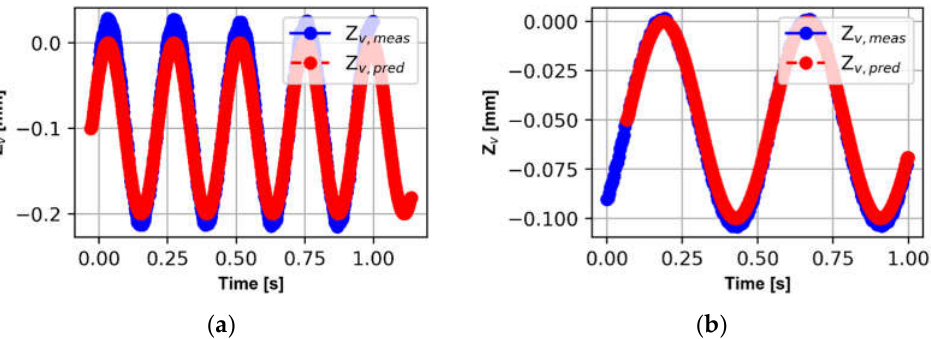
Figure 6. Superposed vibration motions of modeling and measurements: ( a ) A = 0.1 mm and freq = 4 Hz and ( b ) A = 0.05 mm and f = 2 Hz.